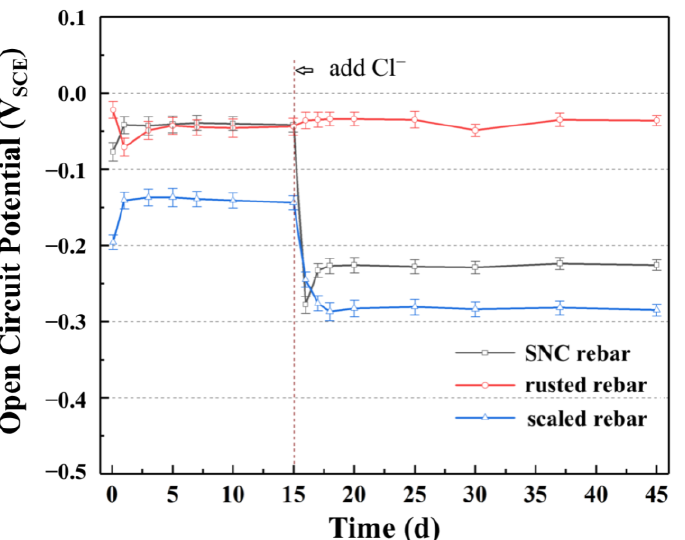
Figure 4. OCP evolution curves of the rebar tested during constant immersion in SCPS without/with chloride ions.